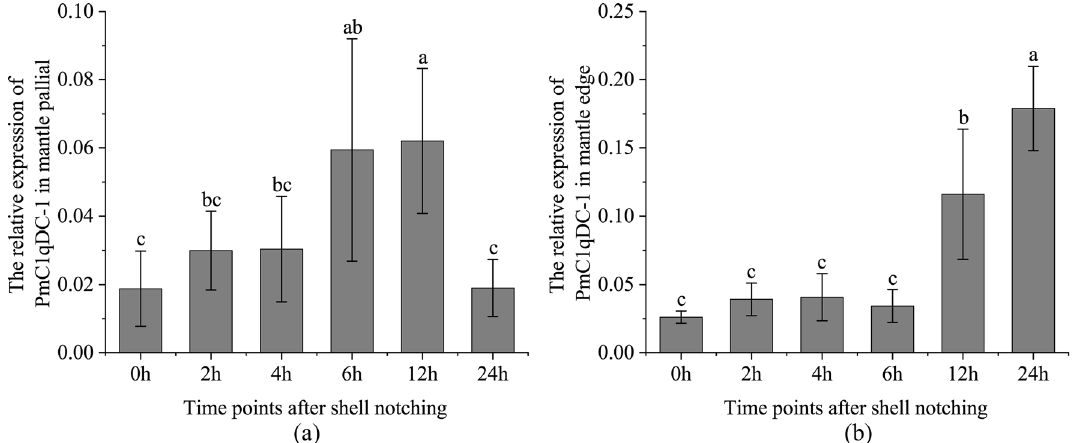
Figure 8. Expression pattern of PmC1qDC-1 in shell damage repair process. ( a ) Expression pattern of PmC1qDC-1 at the mantle pallial after shell notching. ( b ) Expression pattern of PmC1qDC-1 at the mantle edge after shell damage. The averages of the groups with the different lower-case letters (a, b, c) were significantly different (P < 0.05). The averages of the groups with the same lowercase letters (a, b, c) are not significantly different (P >